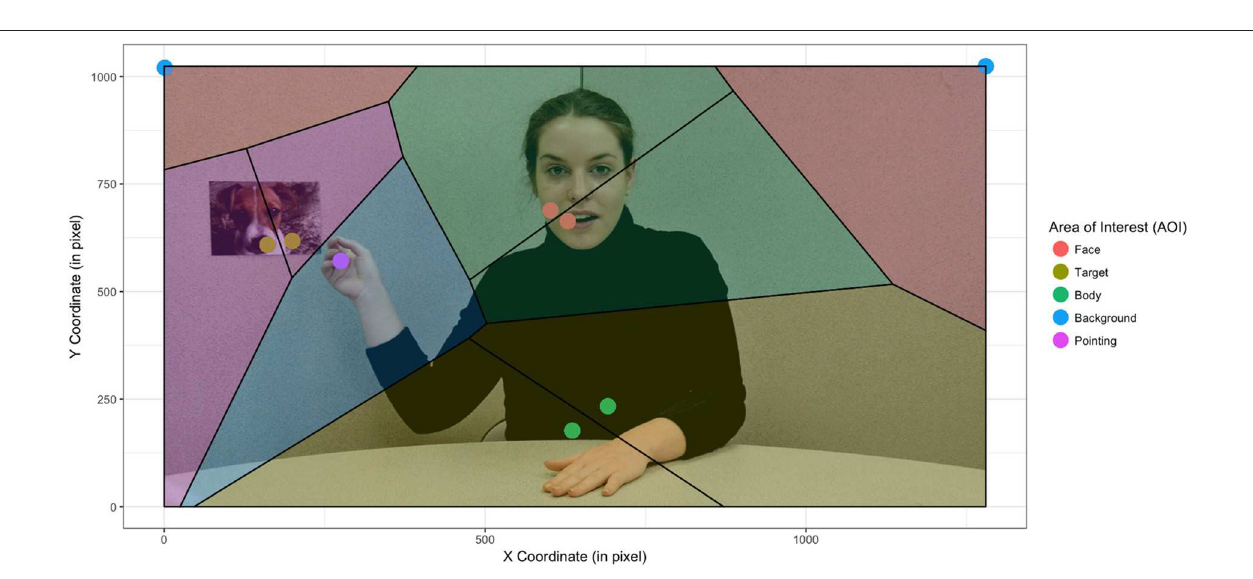
photos, they made longer fixations on “Face” AOI (M =